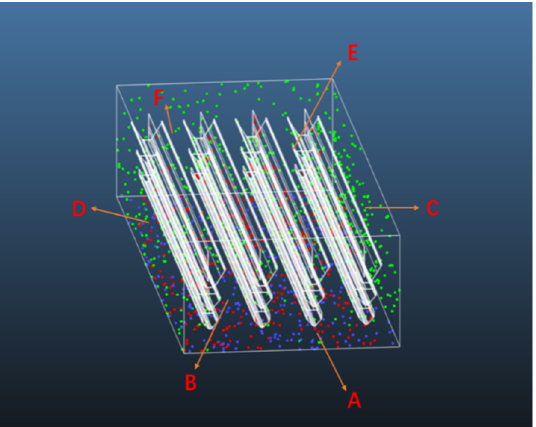
Figure 3. The Molflow model. (A—the lower wall; B—the front wall; C—the right wall; D—the left wall; E—the rear wall; F—the upper wall).